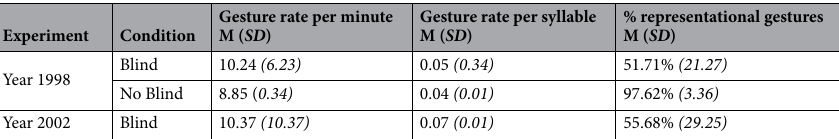
Table 2. Gesture rates. Standard deviations refer to variability across the different videos. Gesture rates with student populations show similar gesture rates with these cartoons, showing of about 10 representational gestures per minute 24